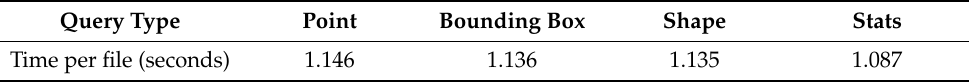
Table 4. Average Time Per Data File to Query Remote Datasets Using